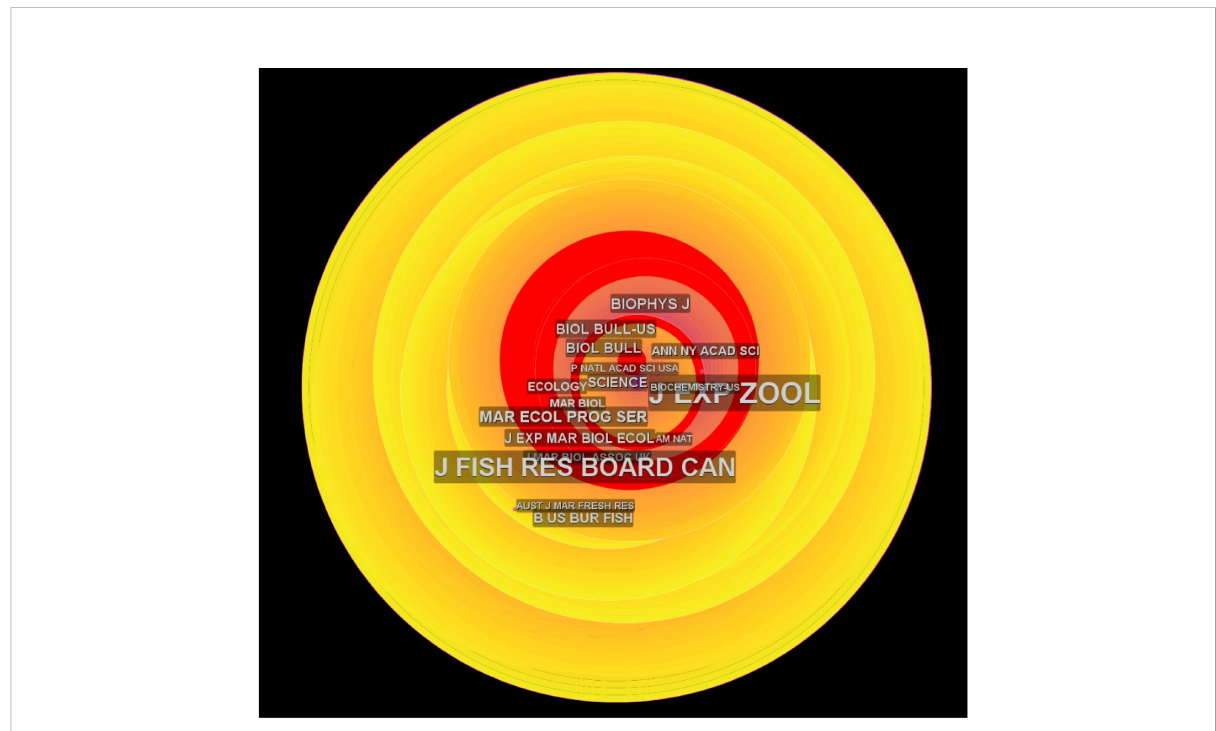
FIGURE 5 The knowledge maps for journal co-citation analysis. The larger the formatted name of the journal, the more in fl uential it was in lobster research.